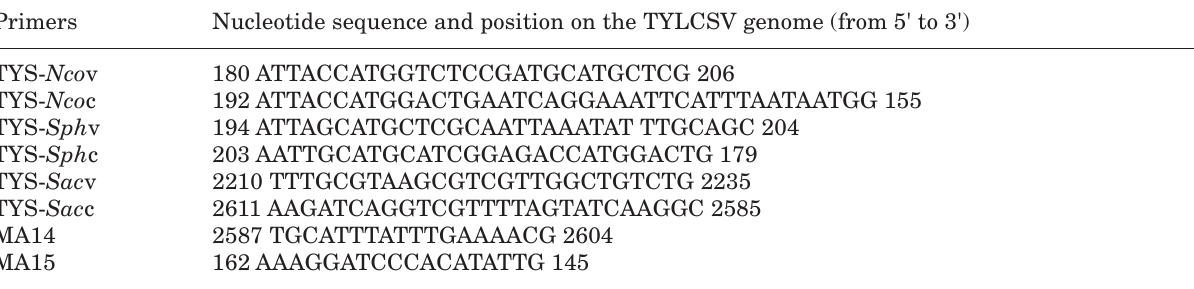
Table 1. Overlapping primers used in the polymerase chain reaction to amplify fragments and full-length TYLCSV from